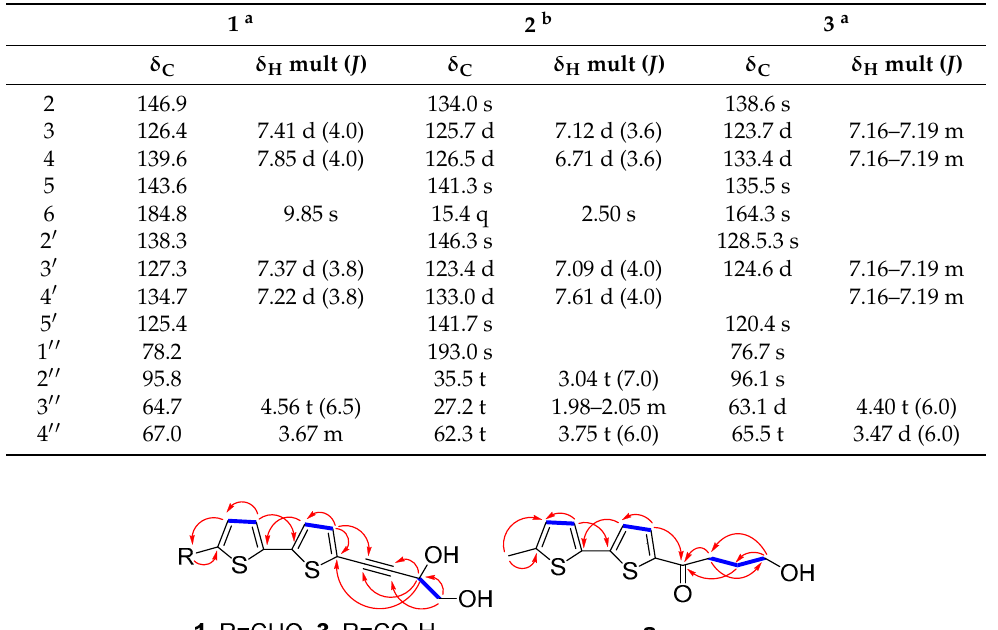
Table 1. 1 H-NMR (500 MHz) and 13 C-NMR (125 MHz) data of 1 – 3 ( a is recorded in methanol- d 4 ; b is